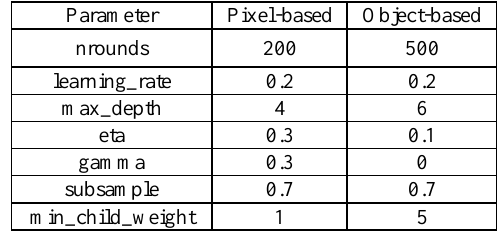
Table 2 . Wining values of hyperparameter tuning of Xgboost model using a grid search approach and optical + SAR